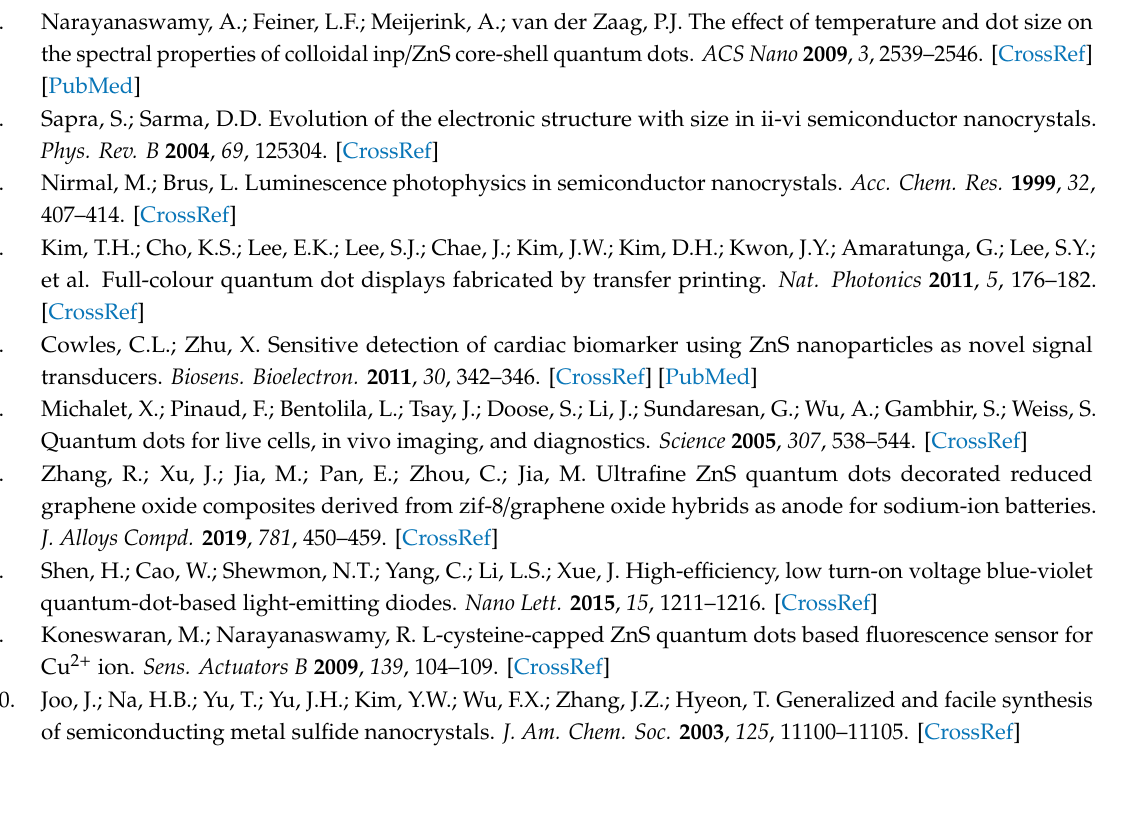
Figure S1: HRTEM images of Q-ZnS-c nanocrystals, showing twinning structures and agglomeration behavior; Figure S2: TEM images of ZnS samples synthesized through mechanochemical route without SDBS, indicating the large aggregates of